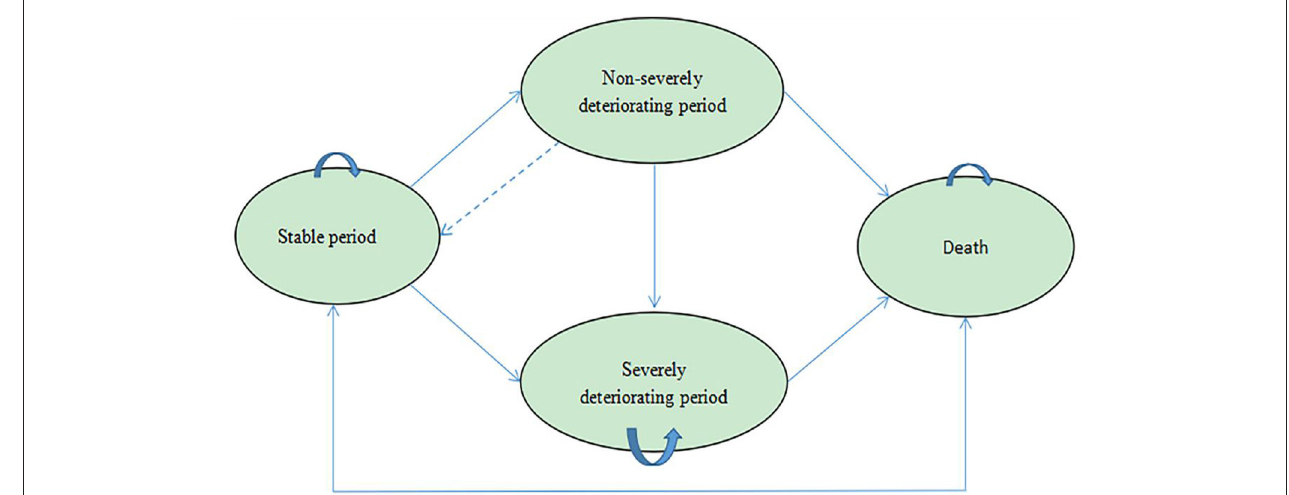
FIGURE 1 | Model structure.